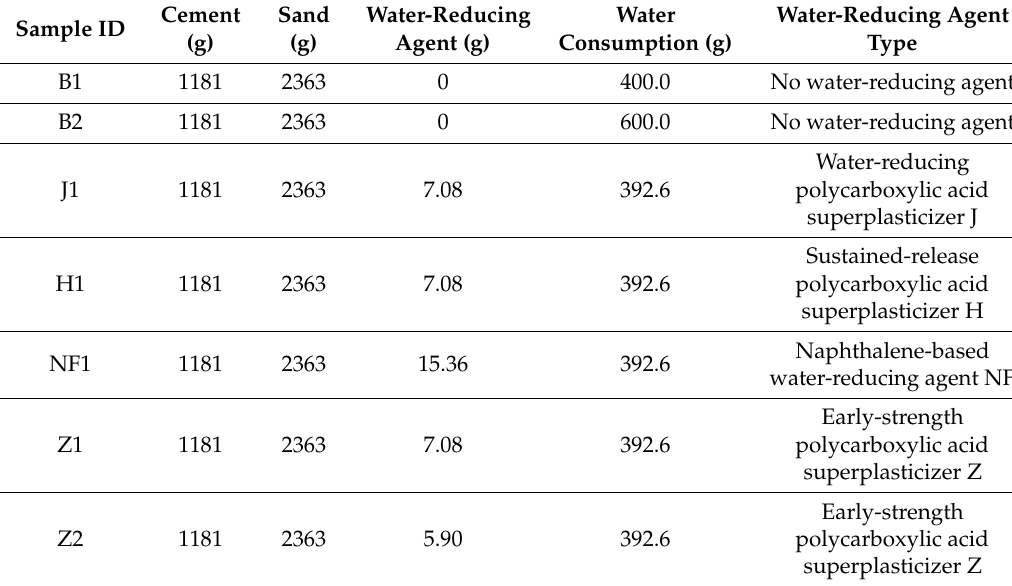
Table 3. Mix ratio of the cement